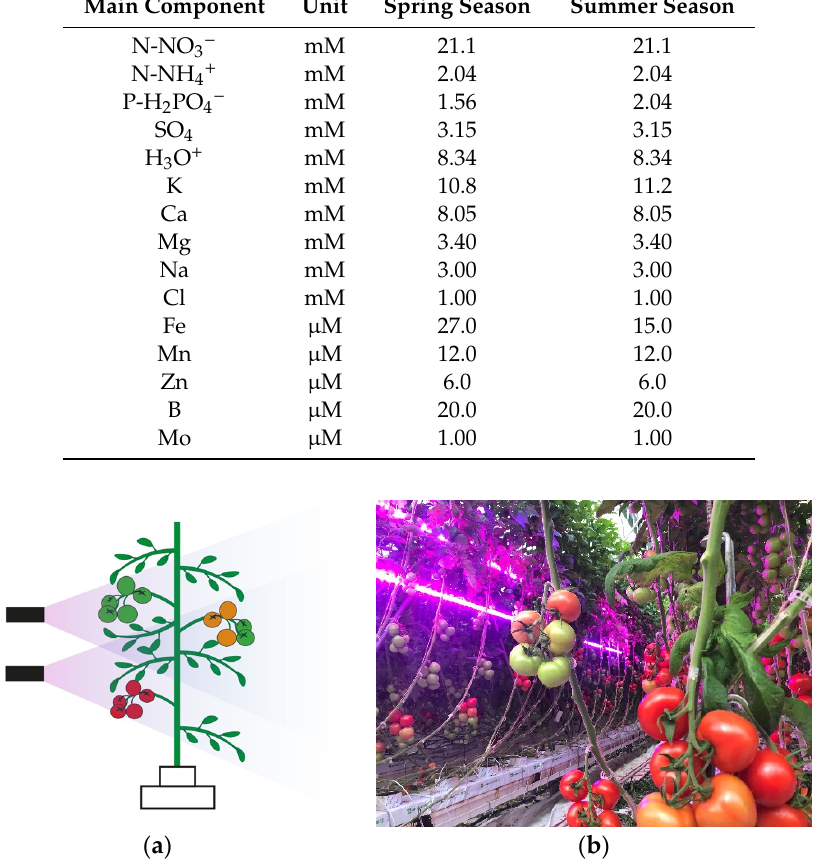
Table 1. Nutrient solution composition adopted in iPOM greenhouse during spring and summer season.